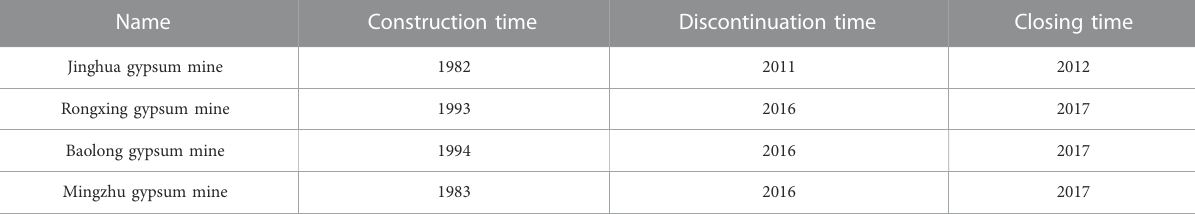
TABLE 1 Basic information of mines in the survey